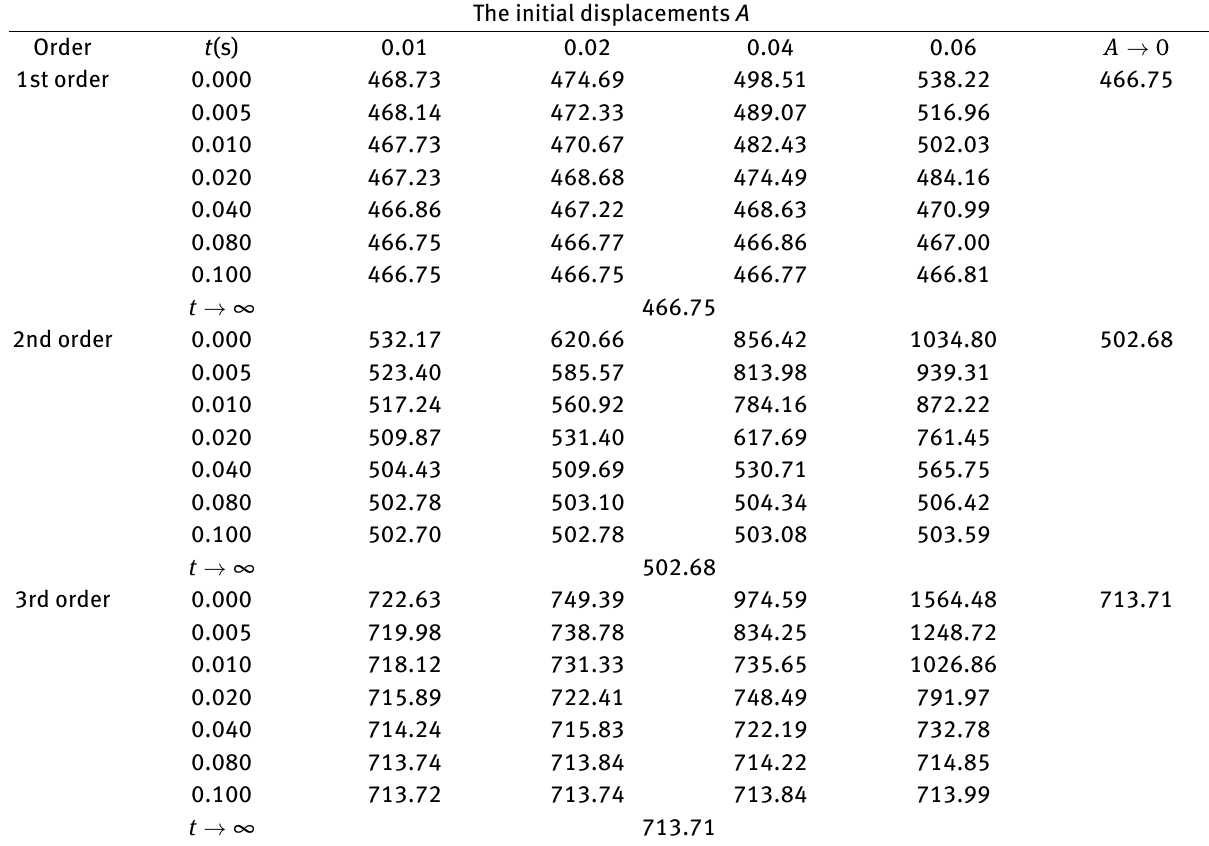
Table 1: The frequency (rad/s) under different initialdisplacements and time instants when the rise span ratio is 1/10 The initial displacements